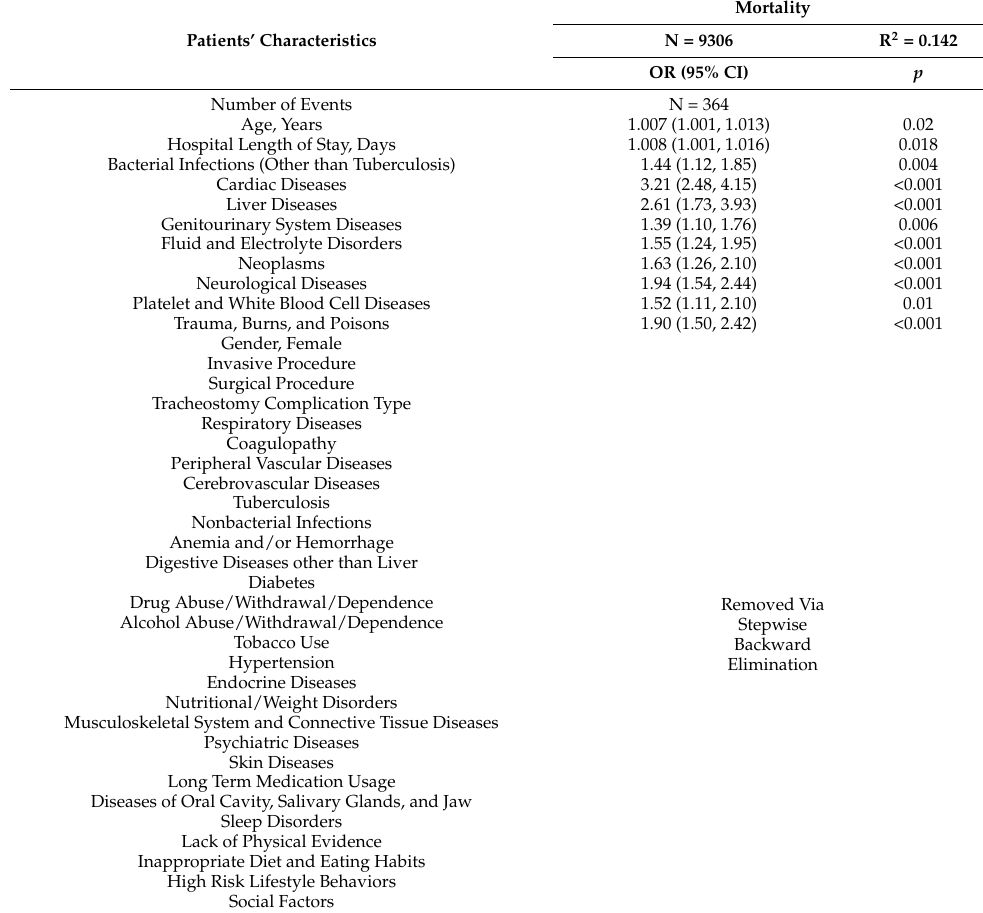
Patients’ Characteristics